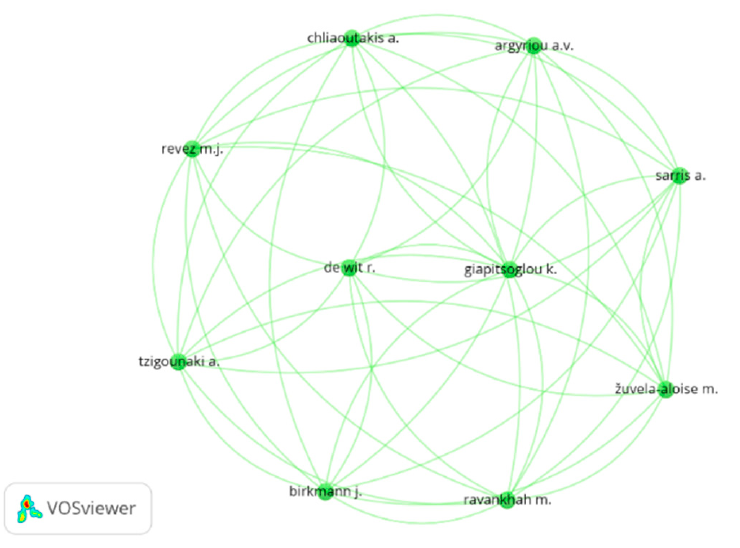
Figure 7. Less productive co-author network. Source: own elaboration.